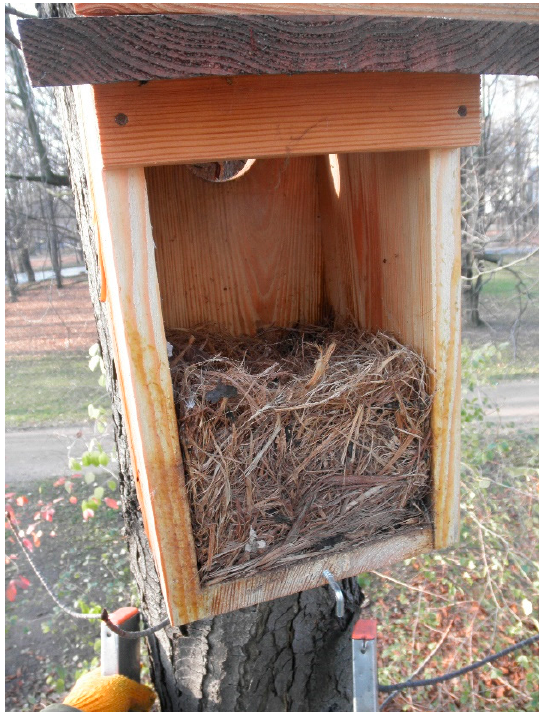
Figure A2. A check of the nest box dedicated to the red squirrel; the front panel is removed. The box was occupied by the target species (photo by Adam Tarłowski).